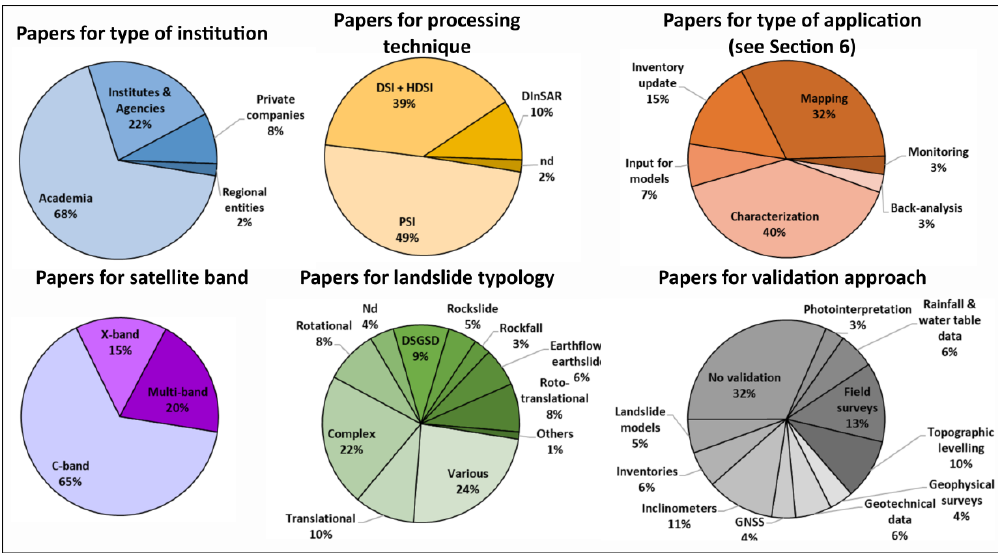
Figure 3. Pie charts showing significant statistics extracted from the review database.